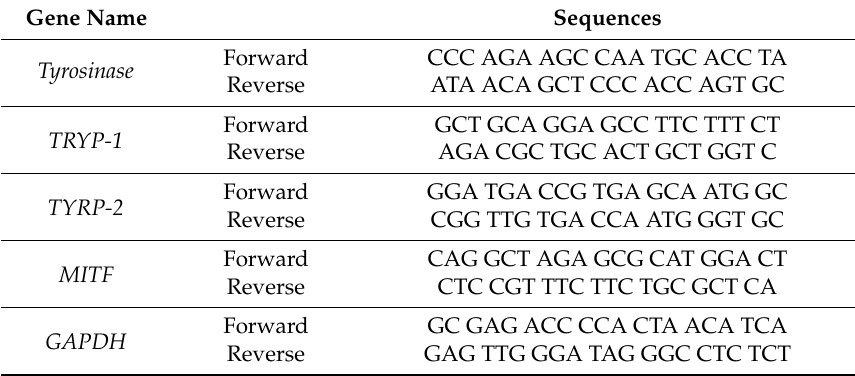
Table 1. List of the primer used in this